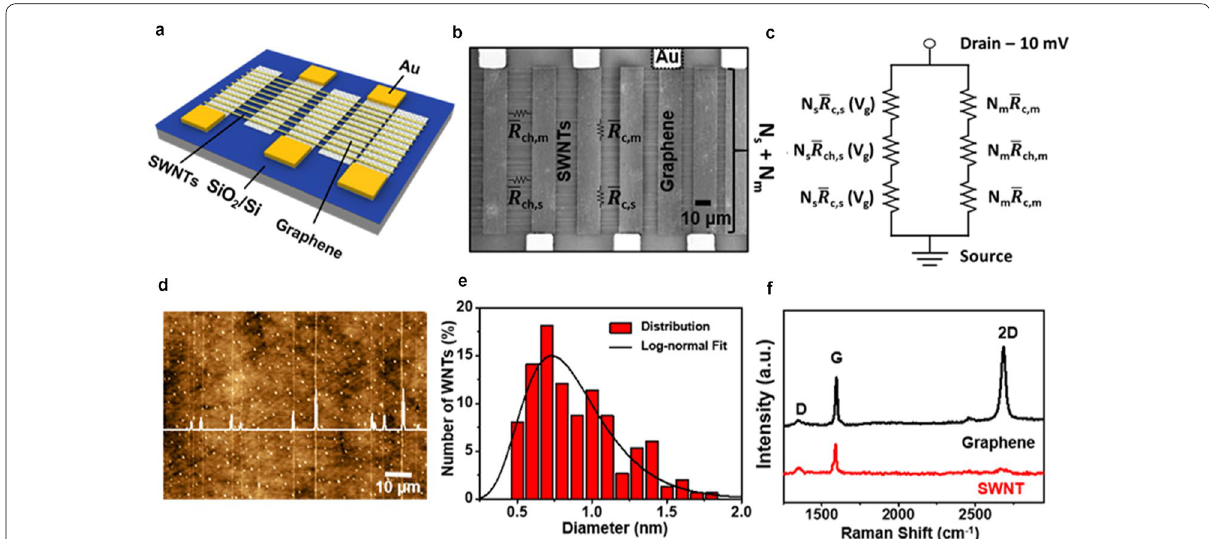
Fig. 1 Schematic illustration ( a ) and SEM image ( b ) of graphene/SWCNTs junction TLM test structure. c Equivalent circuit model for graphene/SWC- NTs junction transistor. d AFM image of CVD grown SWCNTs. e Typical diameter distribution of SWCNTs measured by AFM. f The Raman spectra for graphene and